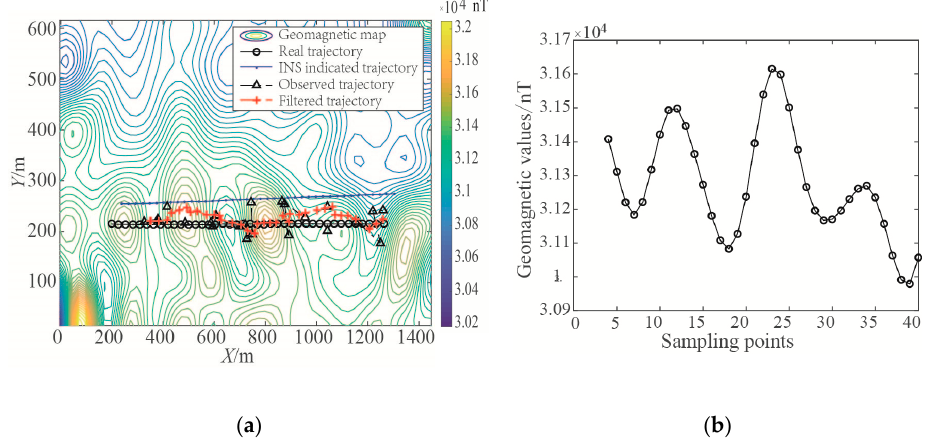
Figure 13. Geomagnetic filtering result. ( a ) Filtering results of the geomagnetic filter subsystem; ( b ) The magnetic values along the trajectory.